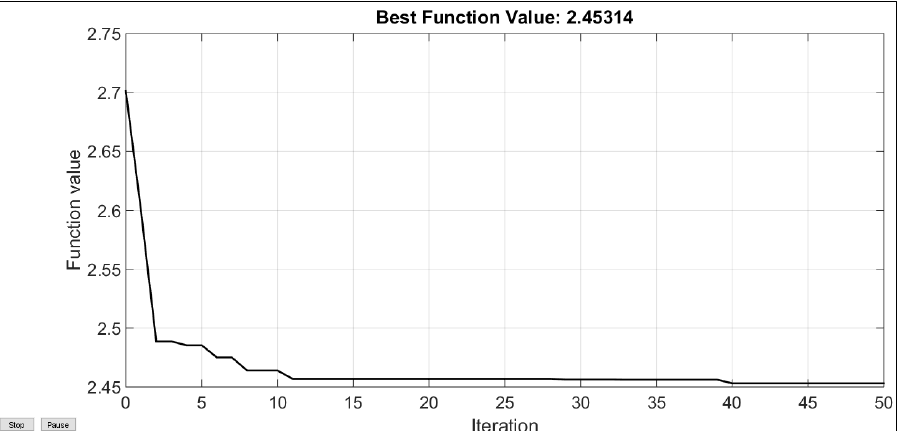
Figure 18. Fitness function of PSO algorithm to tune PID coefficients